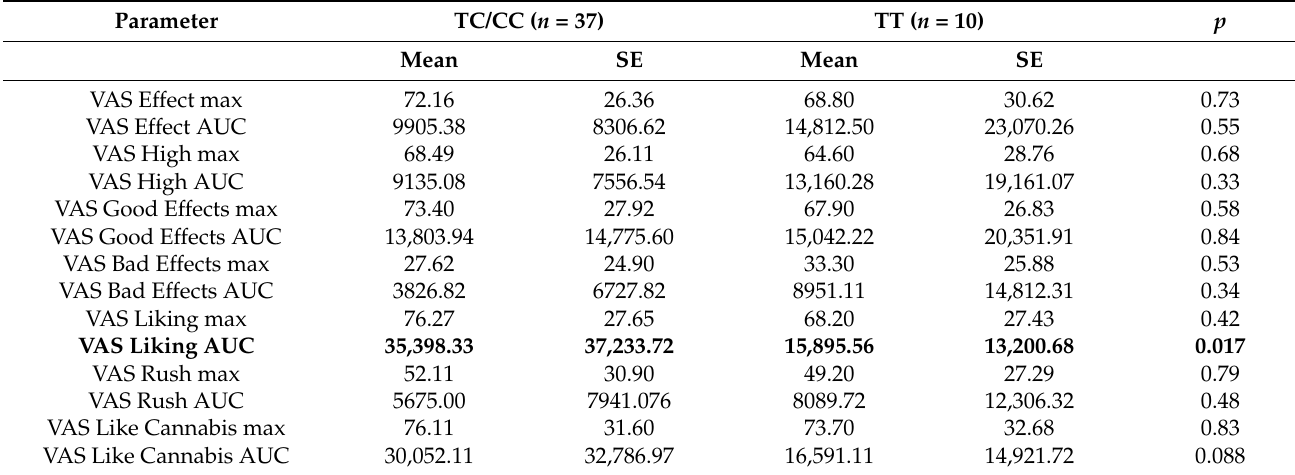
Table 3. VAS maximum effect and Area-under-the-Curve